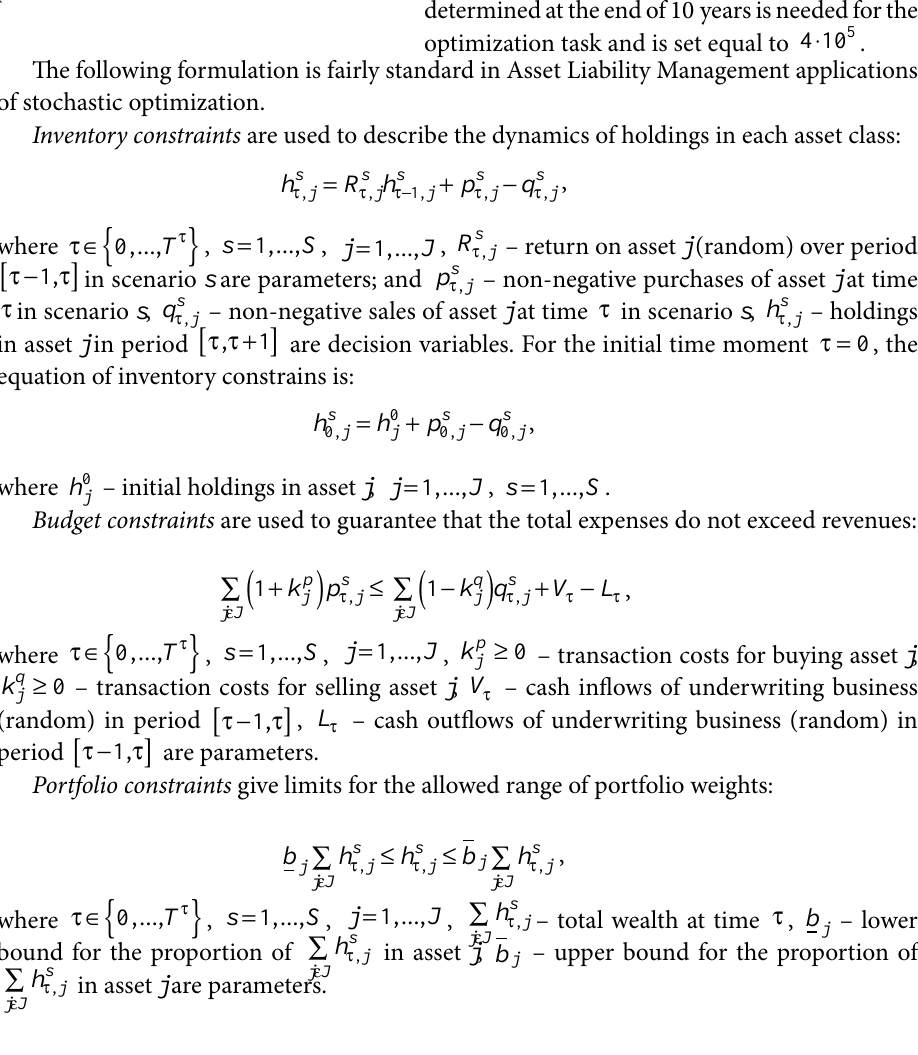
Fig. 13. 5-stage scenarios tree of stochastic